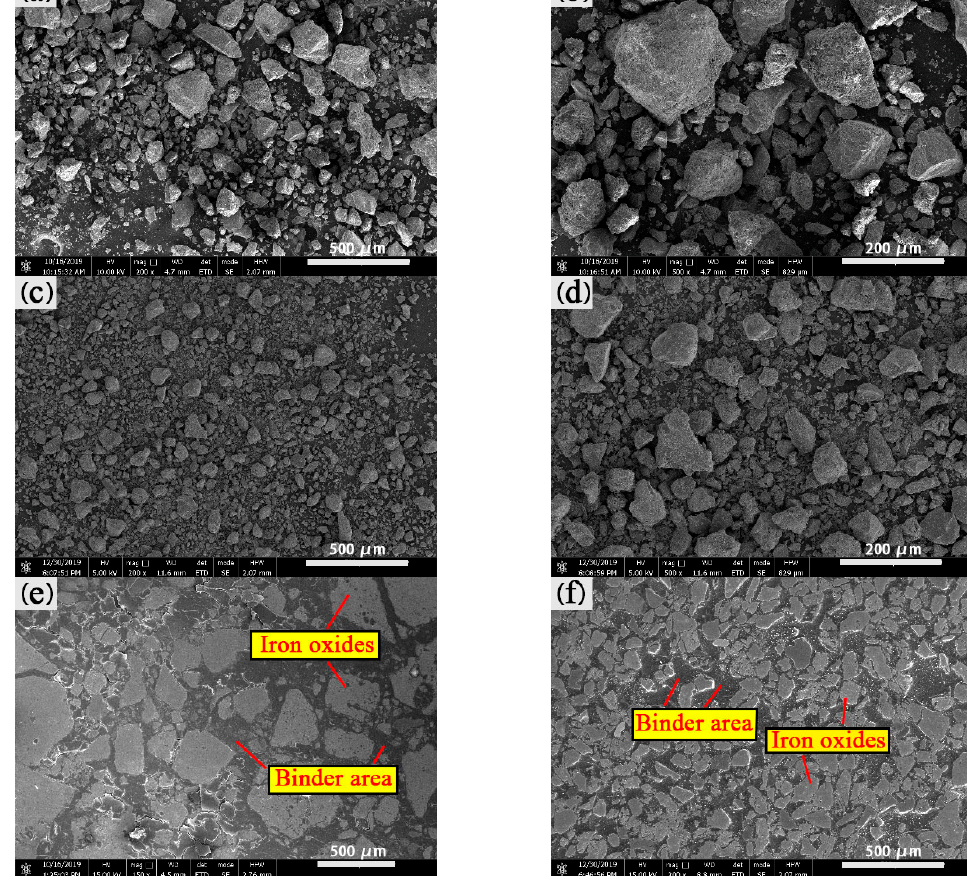
Figure 8. SEM images of sample A ( a , b ), sample B ( c , d ), sample AC ( e ) and sample BC ( f ). The compressive strengths of samples AC and BC with dry and heat ‐ treated at 500 °C conditions are shown in Figure 9. It can be seen that the compressive strength of the two samples decreases after 30 min at 500 °C in the muffle furnace (air atmosphere). The compressive strength of sample AC heat ‐ treated at 500 °C can reach 341.62 N, which is 16.73% of the compressive strength value of dry sample AC. The compressive strength of sample BC heat ‐ treated at 500 °C can reach 194.65 N, which is 18.80% of dry sample BC. The compressive strength values of heat ‐ treated samples AC and BC are nearly one ‐ fifth of dry samples AC and BC. In addition, it can be inferred from the information provided by Figure 6 that the binder still has a bonding effect after holding CBB at 500 °C for 30 min, while the remaining 10% mass [19], mechanical interlocking force, van der Waals bonding and electrostatic forces, etc., also contribute to the compressive strength of the CBB [20].